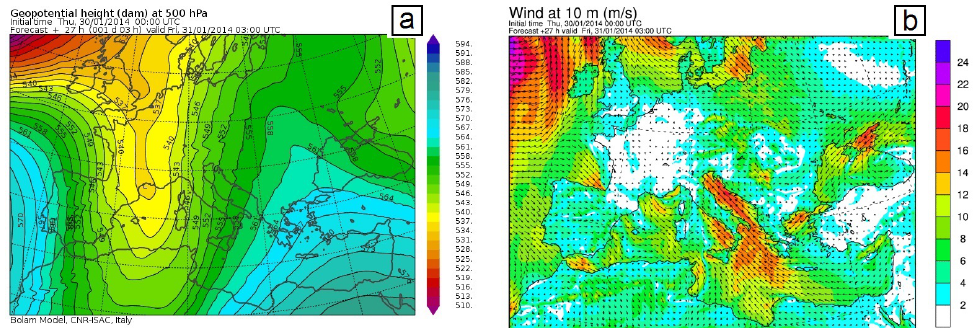
Figure 5. 31 January 2014 03:00 UTC: ( a ) Geopotential height (dam) at 500 hPa; ( b ) Wind (m/s) at 10 m (Bolam simulations).